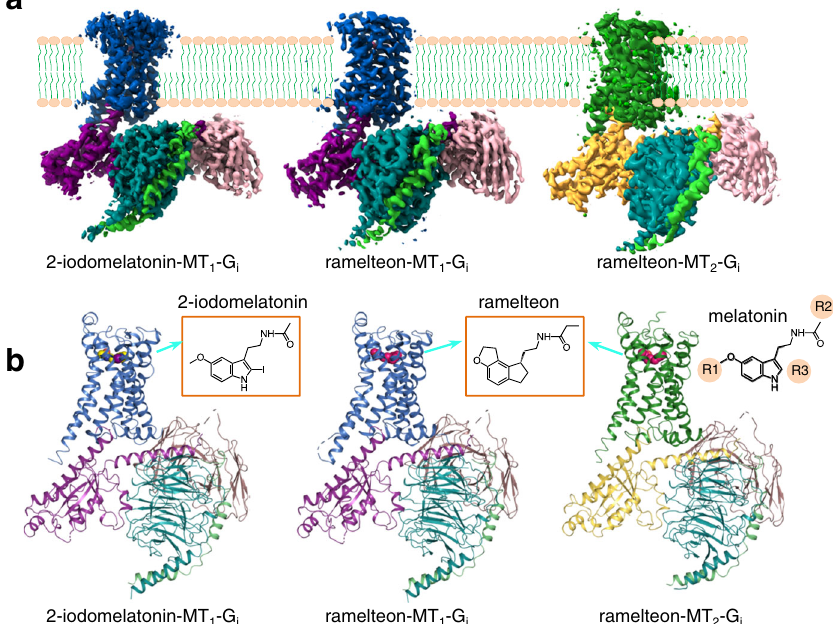
Fig. 1 Overall structures of the MT 1 -G i and MT 2 -G i signaling complexes. a Cryo-EM density maps of the MT 1 -G i and MT 2 -G i complexes. The color code is as follows: MT 1 , blue; MT 2 , green; G α i in MT 1 , purple; G α i in MT 2 , yellow; G β , teal; G γ , light green; scFV16, violet. b Cryo-EM structures of the MT 1 -G i and